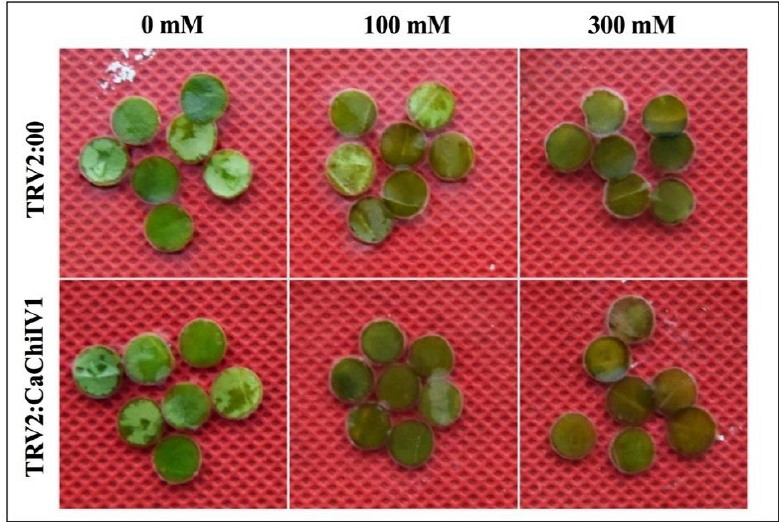
Figure 12. The CaChiIV1 -silenced pepper plants reduced resistance to NaCl stress. Leaf discs phenotypes (0.5 cm in diameter) of the TRV2:CaChiIV1 and TRV:00 plants in response to 0 mM, 100 mM and 300 mM NaCl stress after 48 h.